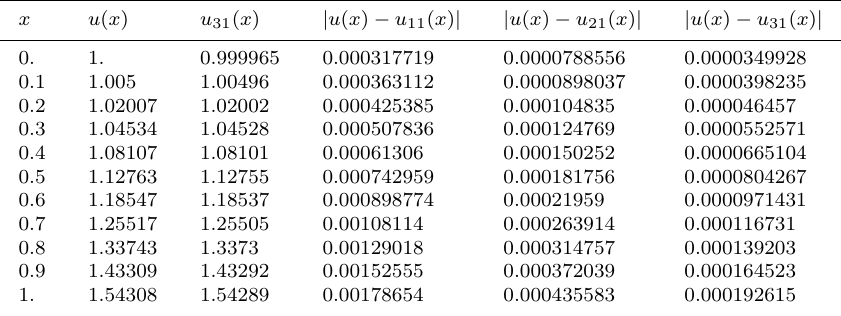
Table 1. The numerical results for Example